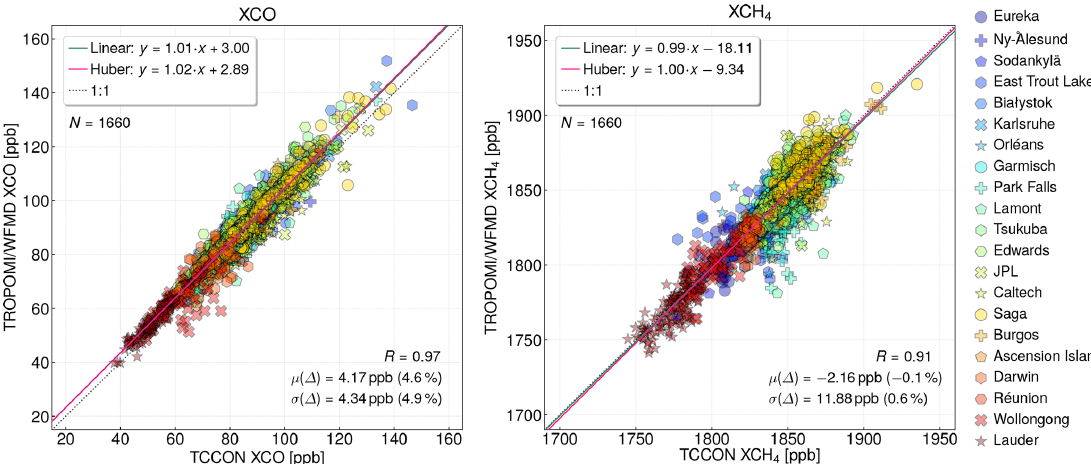
Figure 12. Comparison of the TROPOMI/WFMD data to the TCCON based on daily means. Specified are the linear regression results and the correlation of the data sets, as well as the mean and standard deviation of the difference. To analyse the impact of outliers, the regression is also performed for the Huber linear regression model, which is robust to